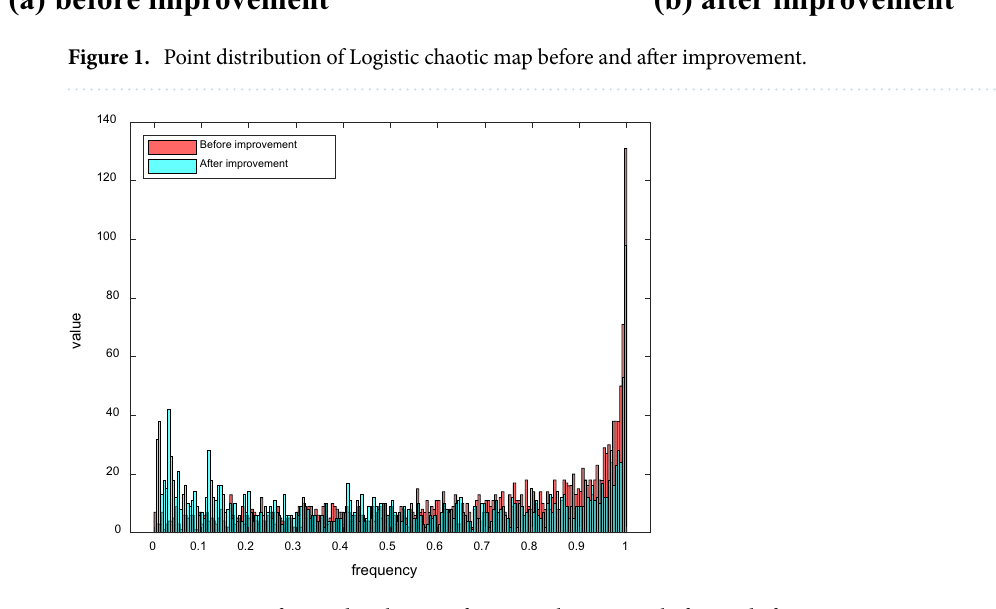
Figure 2. Histogram of point distribution of Logistic chaotic map before and after